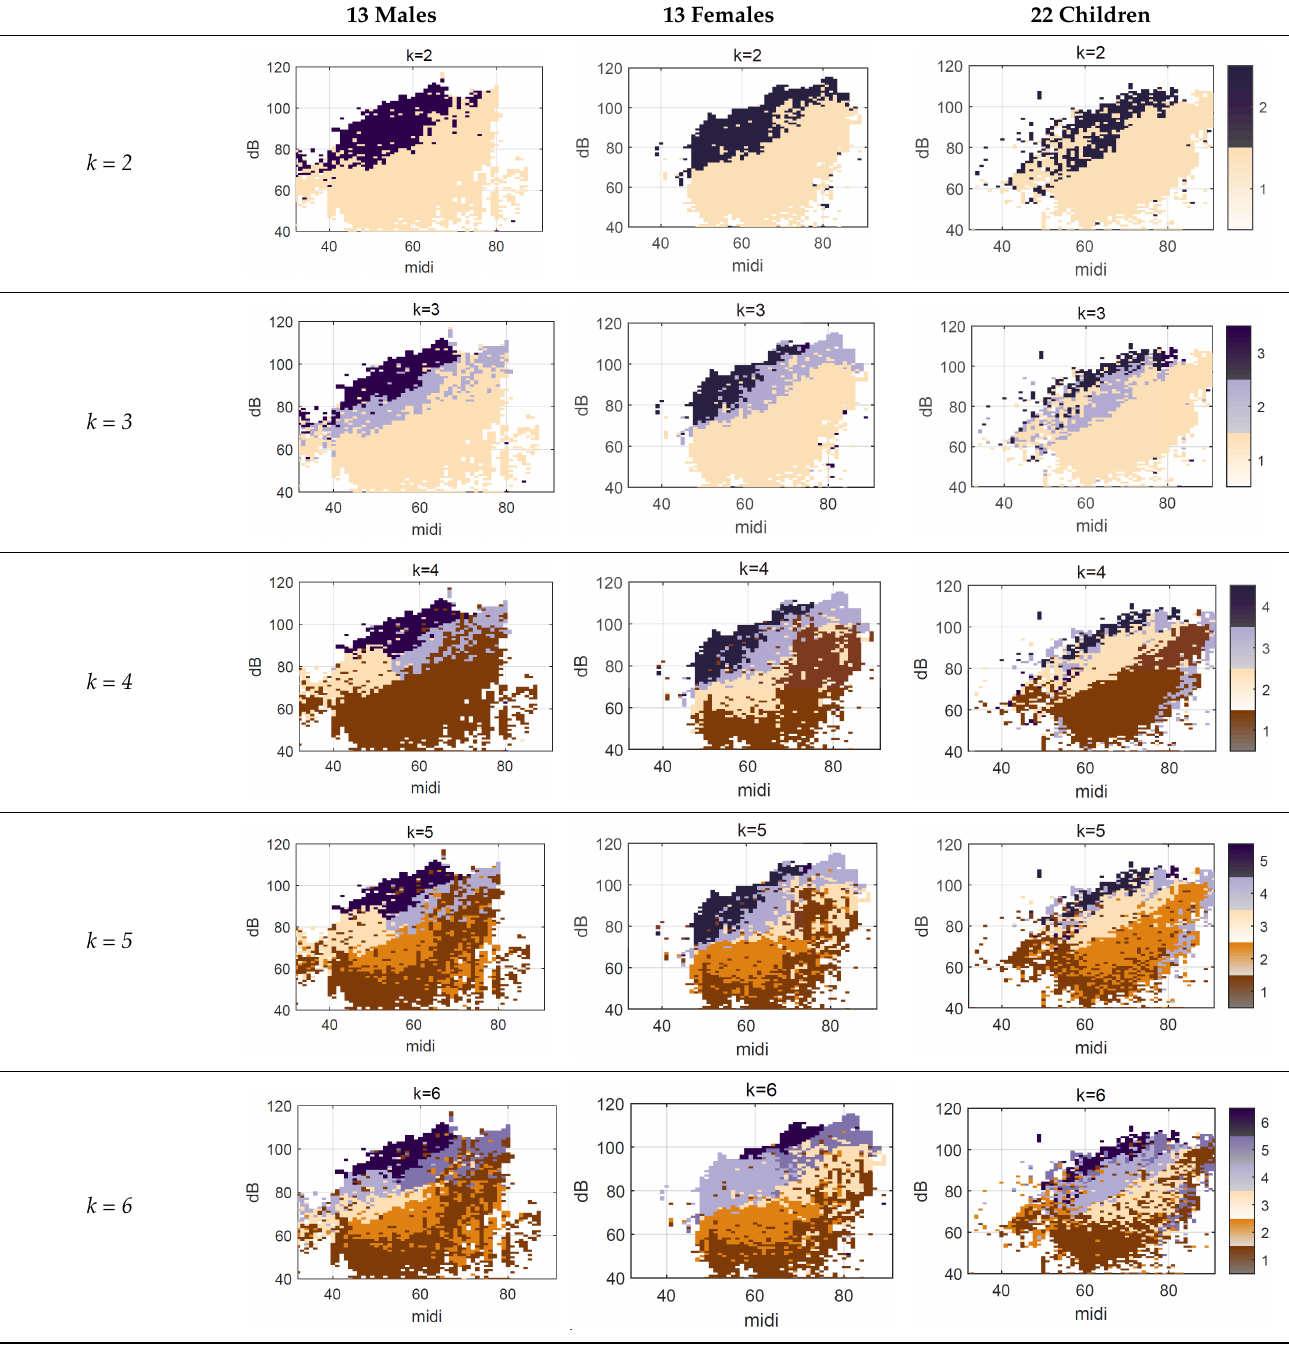
Table 3. ‘Union’ maps of phonation types that display the majority count of all the cluster data in one Table 3. ‘ Union’ maps of phonation types that display the majority count of all the cluster data in group. The columns represent the groups: 13 males, 13 females, and 22 children. The rows represent Table 3. ‘ Union’ maps of phonation types that display the majority count of all the cluster data in Table 3. ‘ Union’ maps of phonation types that display the majority count of all the cluster data in Table 3. ‘ Union’ maps of phonation types that display the majority count of all the cluster data in Table 3. ‘ Union’ maps of phonation types that display the majority count of all the cluster data in Table 3. ‘ Union’ maps of phonation types that display the majority count of all the cluster data in Table 3. ‘ Union’ maps of phonation types that display the majority count of all the cluster data in Table 3. ‘ Union’ maps of phonation types that display the majority count of all the cluster data in Table 3. ‘ Union’ maps of phonation types that display the majority count of all the cluster data in one group. The columns represent the groups: 13 males, 13 females, and 22 children. The rows rep- one group. The columns represent the groups: 13 males, 13 females, and 22 children. The rows rep- one group. The columns represent the groups: 13 males, 13 females, and 22 children. The rows rep- the cluster number k from 2 to 6. The x -axis is f o in semitones (on the MIDI scale, 48 = 110 Hz), and one group. The columns represent the groups: 13 males, 13 females, and 22 children. The rows rep- one group. The columns represent the groups: 13 males, 13 females, and 22 children. The rows rep- one group. The columns represent the groups: 13 males, 13 females, and 22 children. The rows rep- one group. The columns represent the groups: 13 males, 13 females, and 22 children. The rows rep- one group. The columns represent the groups: 13 males, 13 females, and 22 children. The rows rep- one group. The columns represent the groups: 13 males, 13 females, and 22 children. The rows rep- resent the cluster number k from 2 to 6. The x -axis is f o in semitones (on the MIDI scale, 48 = 110 Hz), resent the cluster number k from 2 to 6. The x -axis is f o in semitones (on the MIDI scale, 48 = 110 Hz), resent the cluster number k from 2 to 6. The x -axis is f o in semitones (on the MIDI scale, 48 = 110 Hz), the y -axis is SPL in dB(C) at 0.3 m. resent the cluster number k from 2 to 6. The x -axis is f o in semitones (on the MIDI scale, 48 = 110 Hz), resent the cluster number k from 2 to 6. The x -axis is f o in semitones (on the MIDI scale, 48 = 110 Hz), resent the cluster number k from 2 to 6. The x -axis is f o in semitones (on the MIDI scale, 48 = 110 Hz), resent the cluster number k from 2 to 6. The x -axis is f o in semitones (on the MIDI scale, 48 = 110 Hz), resent the cluster number k from 2 to 6. The x -axis is f o in semitones (on the MIDI scale, 48 = 110 Hz), resent the cluster number k from 2 to 6. The x -axis is f o in semitones (on the MIDI scale, 48 = 110 Hz), and the y -axis is SPL in dB(C) at 0.3 m. and the y -axis is SPL in dB(C) at 0.3 m. and the y -axis is SPL in dB(C) at 0.3 m. and the y -axis is SPL in dB(C) at 0.3 m. and the y -axis is SPL in dB(C) at 0.3 m. and the y -axis is SPL in dB(C) at 0.3 m. and the y -axis is SPL in dB(C) at 0.3 m. and the y -axis is SPL in dB(C) at 0.3 m. and the y -axis is SPL in dB(C) at 0.3 m. 13 Females 22 Children 13 Males 13 Females 22 Children 13 Females 22 Children 13 Females 22 Children 13 Females 22 Children